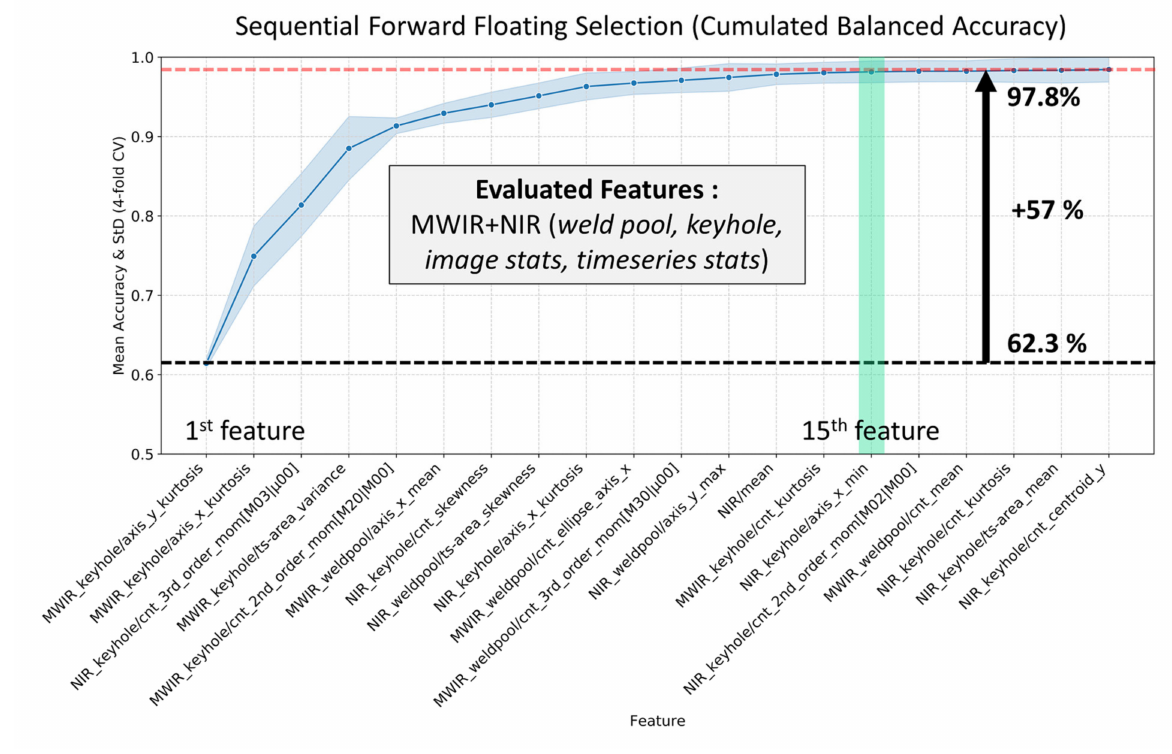
Figure 7. The 20 most important features based on 172 geometrical and statistical characteristics of the weld pool, keyhole and overall image statistics extracted from MWIR images (starting with the